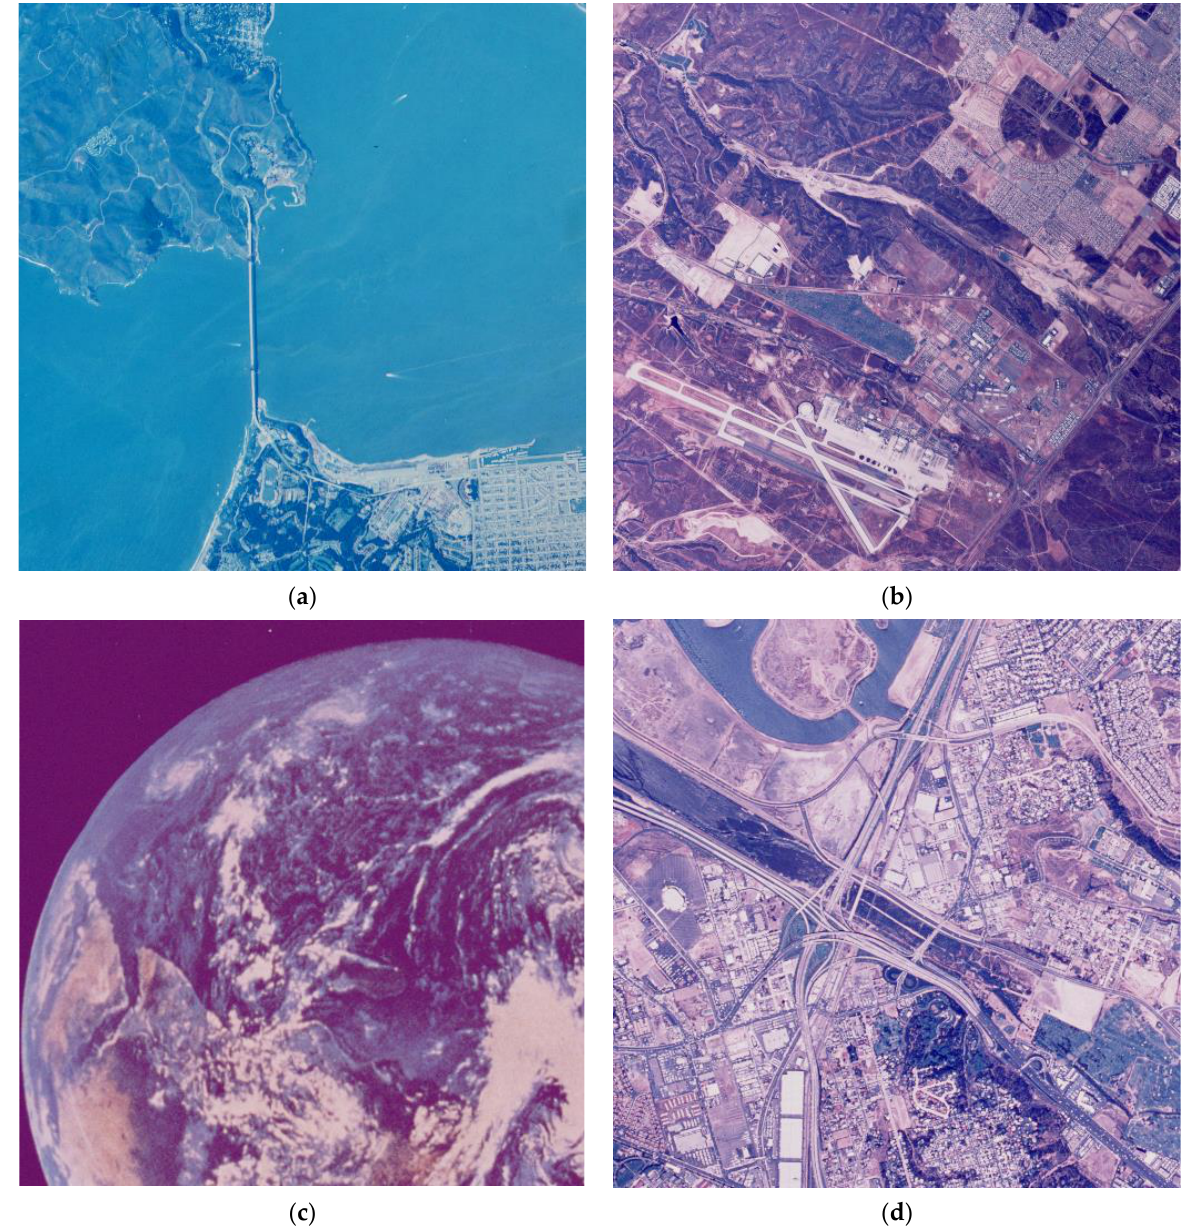
Figure 1. Test three-channel images Frisco ( a ), Diego ( b ), Earth ( c ), and Diego 2 ( d ), all 512 × 512